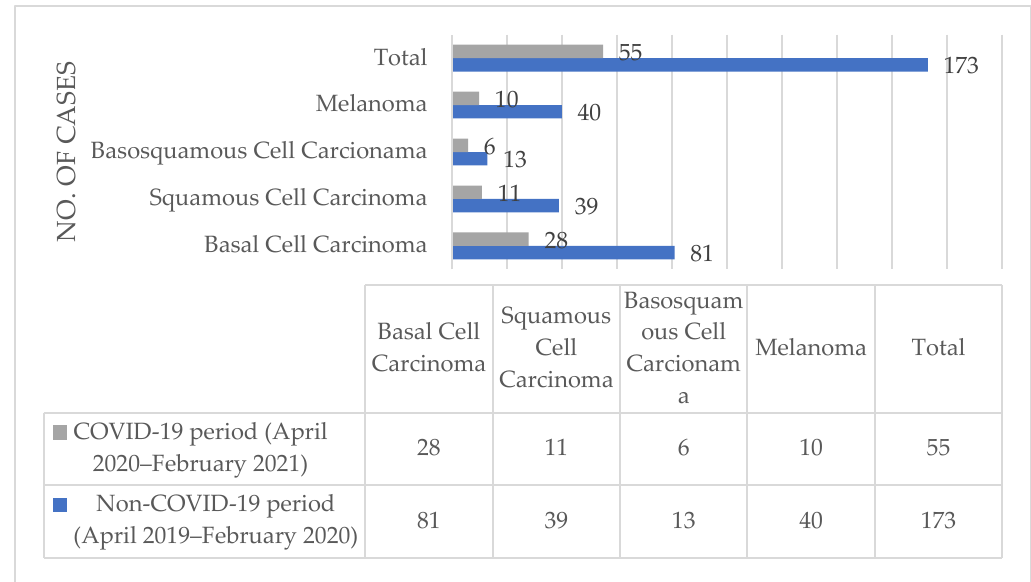
Figure 3. NMSC and melanoma counts from the histopathological diagnoses established between April 2019 and February 2020 and between April 2020 and February 2021 in the dermatopathology ward of Mures Clinical County Hospital, Targu Mures, Romania.